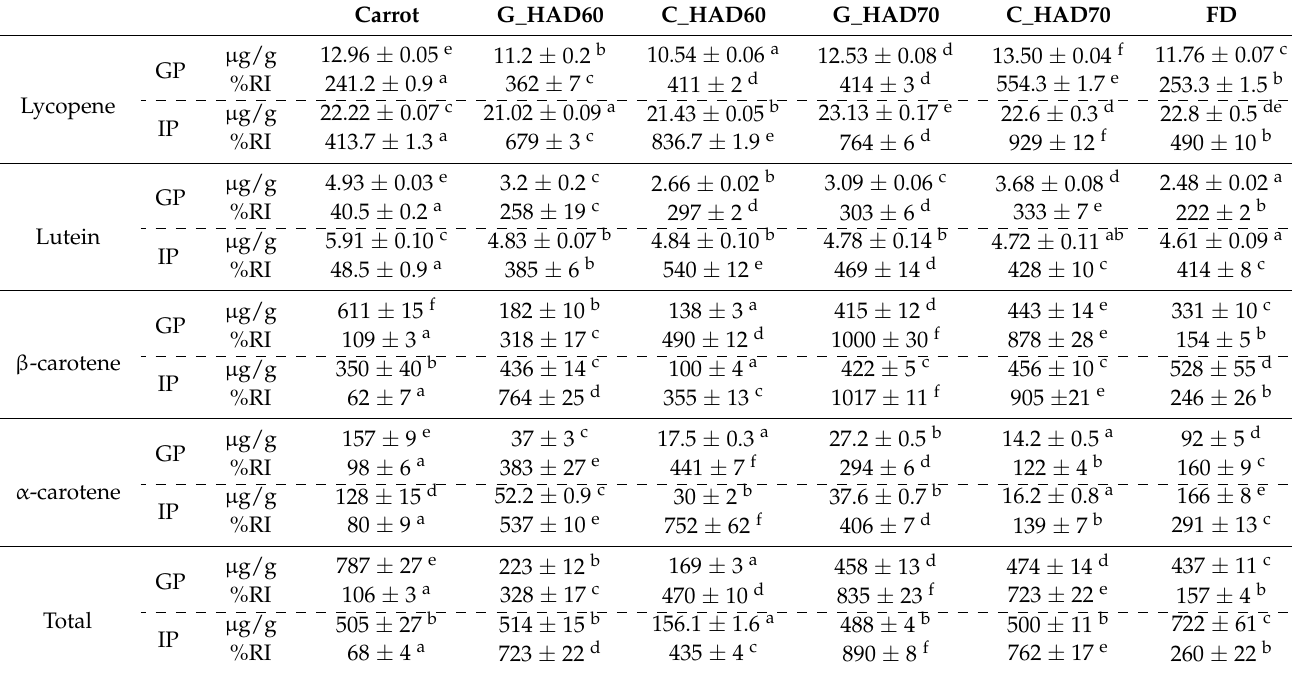
Table 6. Total and individual carotenoid content ( µ g/g of non-digested sample) of carrot waste and carrot powders after the gastric phase (GP) and the intestinal phase (IP). Recovery index in percentage (%RI) after GP and IP. HAD: hot-air drying at 60 and 70 ◦ C, FD: freeze-drying; C: chopped, G: ground. Mean ± standard deviation of four replicates. Carrot G_HAD60 C_HAD60